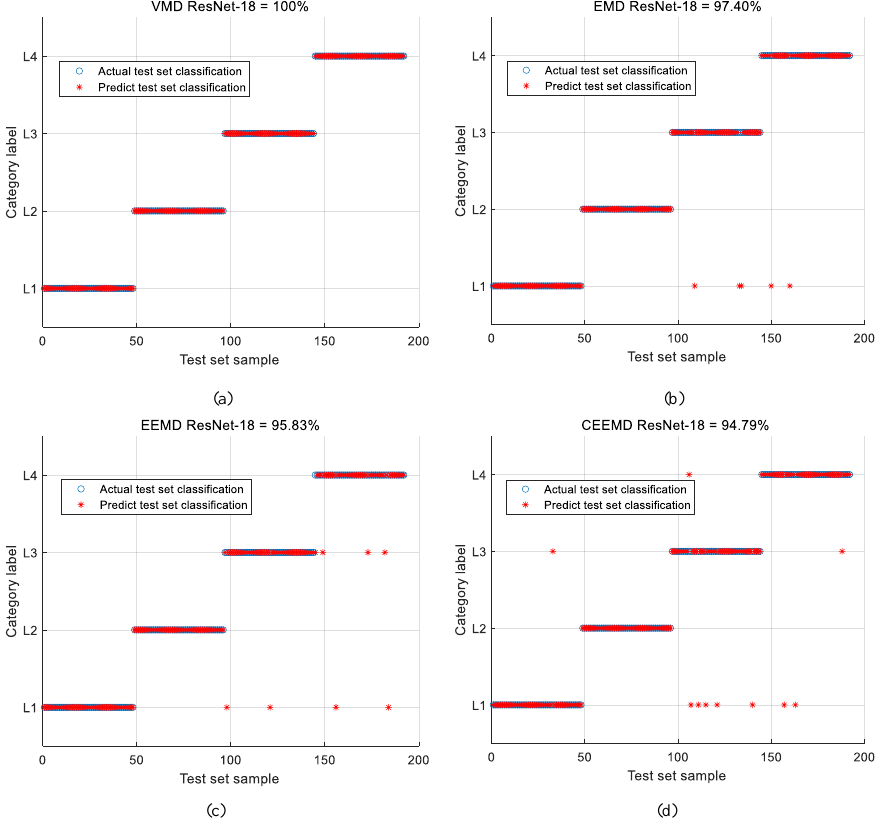
Figure 13. The results of the contrastive analysis of the different mode decomposition diagnoses: ( a ) VMD = 100%; ( b ) EMD = 97.4%; ( c ) EEMD = 95.83%; ( d ) CEEMD = 94.79%.